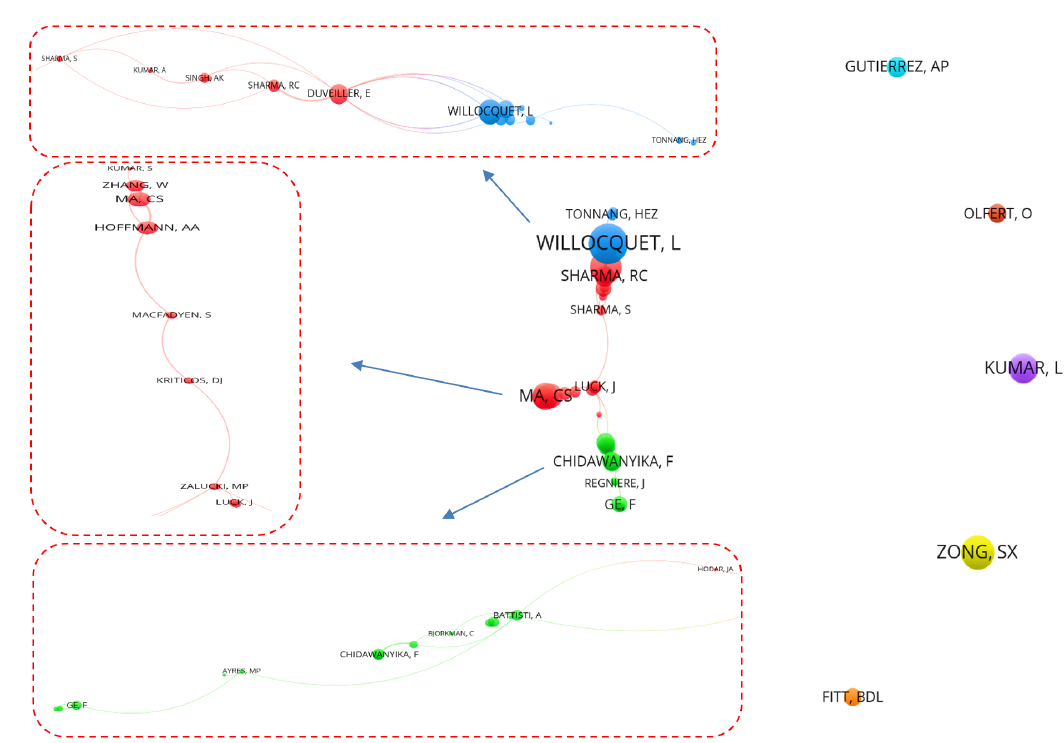
Figure 4. Co-author knowledge domain graph. Table 4. Top 15 institutions in terms of number of published